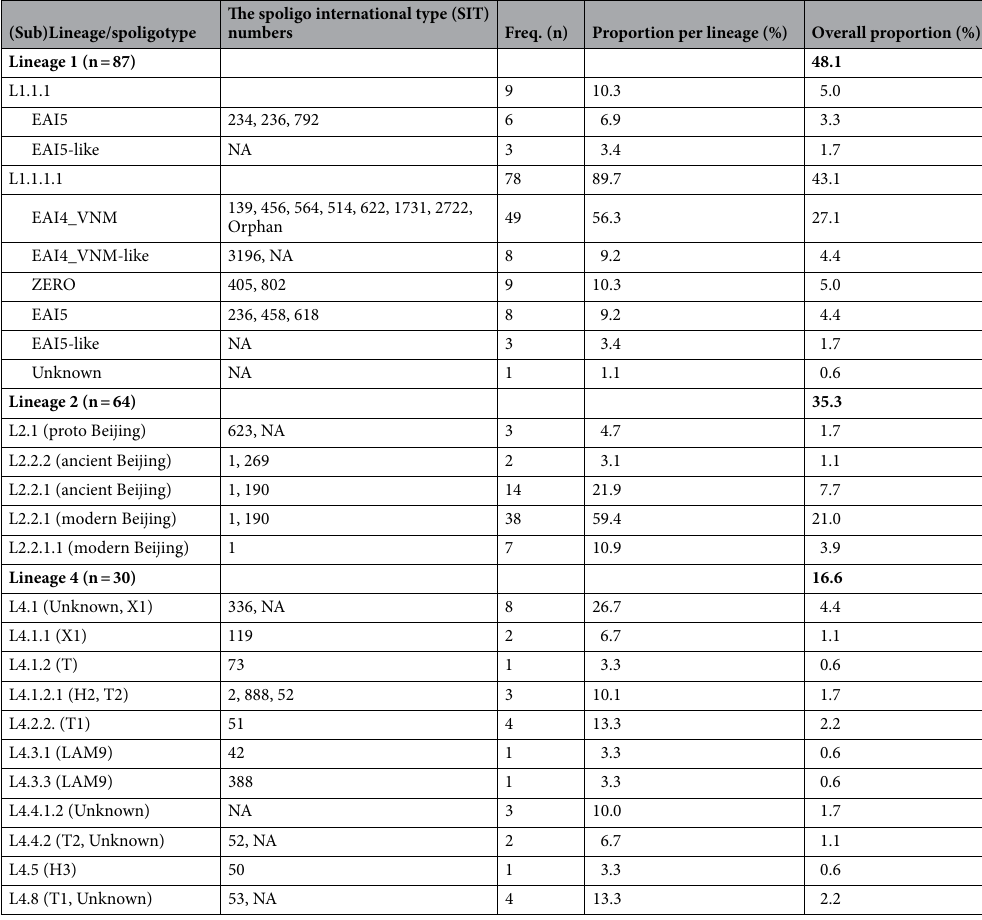
Table 1. Proportions of Mtb lineages/sublineages by the SNP barcode and clades by in-silico spoligotyping in Da Nang samples (N = 181). Mtb Mycobacterium tuberculosis , NA not available, SNP single nucleotide polymorphism. Updated SNP barcode by Napier et al. 5